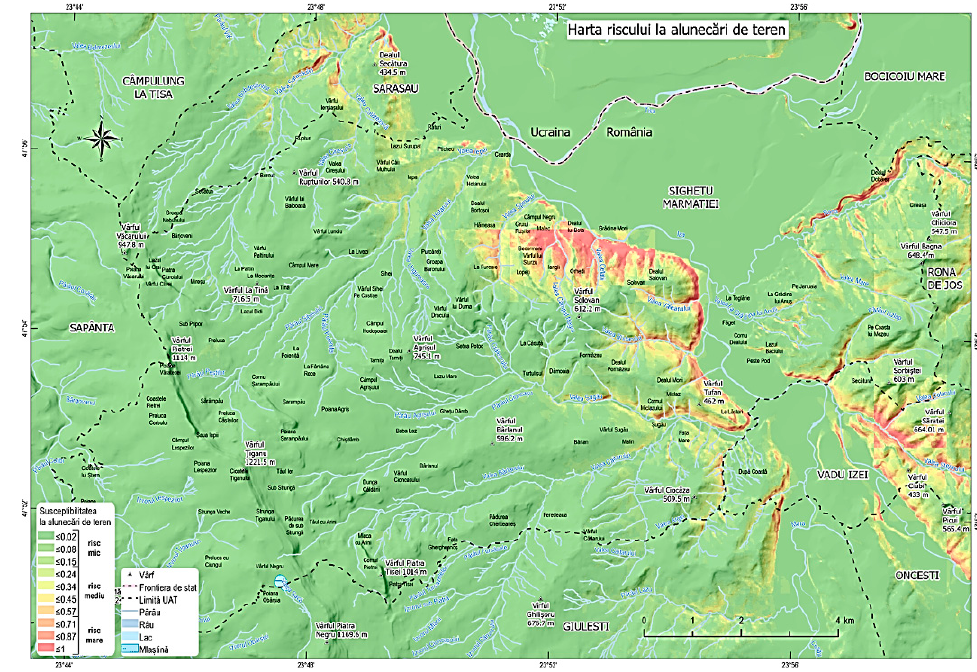
Figure 3. Sighetu Marma ț iei city—map of susceptibility to landslides. Source: GeoSES project [41].